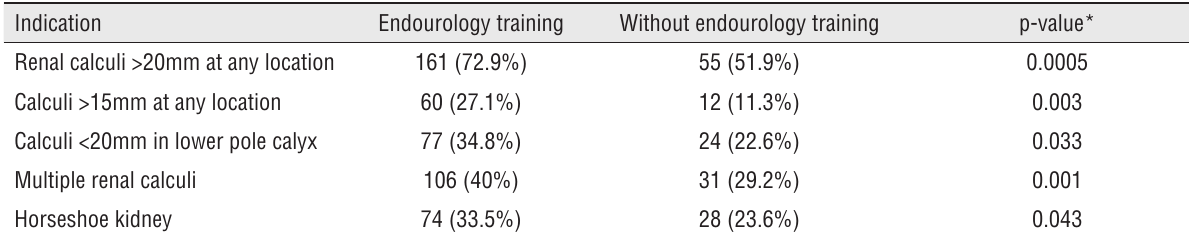
Table 4 - pcNL by indicator among urologists with and without endourology